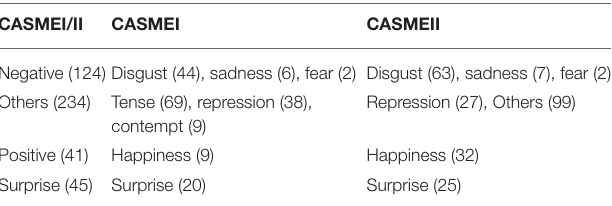
TABLE 3 | Specific emotions in each category and clip numbers in experiment database.